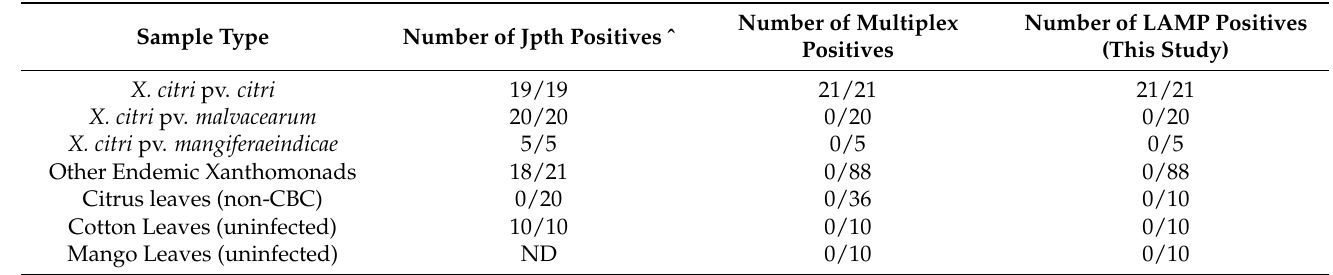
Table 2. Results of LAMP primers designed for X. citri pv. citri specificity compared to the X. citri pv. citri multiplex and Jpth